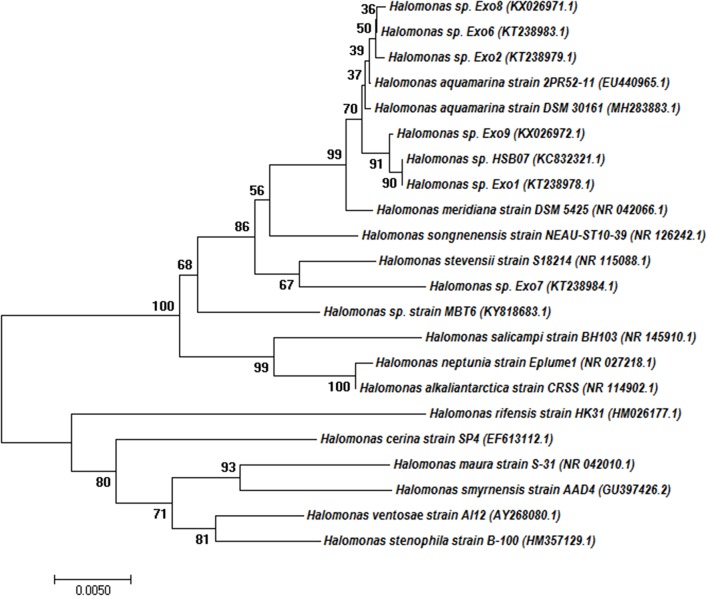
Phylogenetic tree based on 16S rRNA gene sequences obtained by the neighbor-joining (NJ) method showing the phylogenetic relationship of the Halomonas sp. Exo1 with the related species. The percentage of replicate trees in which the associated taxa clustered together in the bootstrap test (1,000 replicates) is shown next to the branches. Branches corresponding to partitions reproduced in <50% bootstrap replicates are collapsed. Accession numbers are written after the species or strain names.